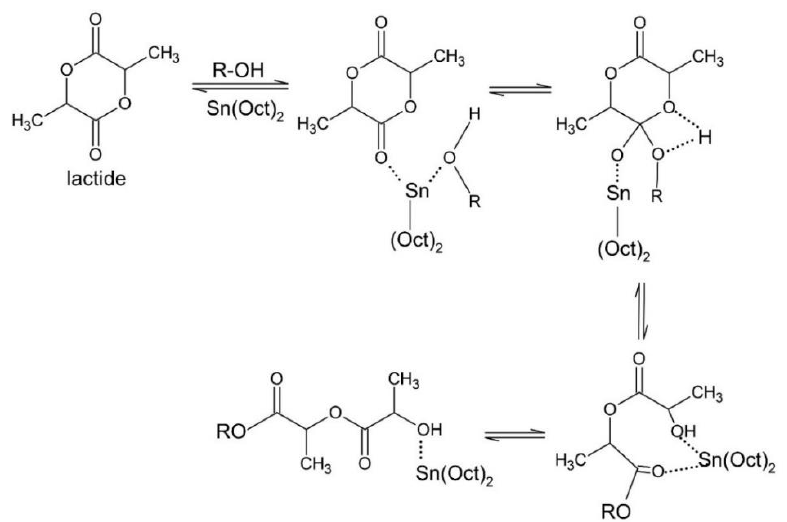
Figure 4. General lactide coordination-insertion mechanism with Sn(Oct) 2 for PLA production (reprinted with permission [18], Copyright 2000 John Wiley & Sons Inc.).